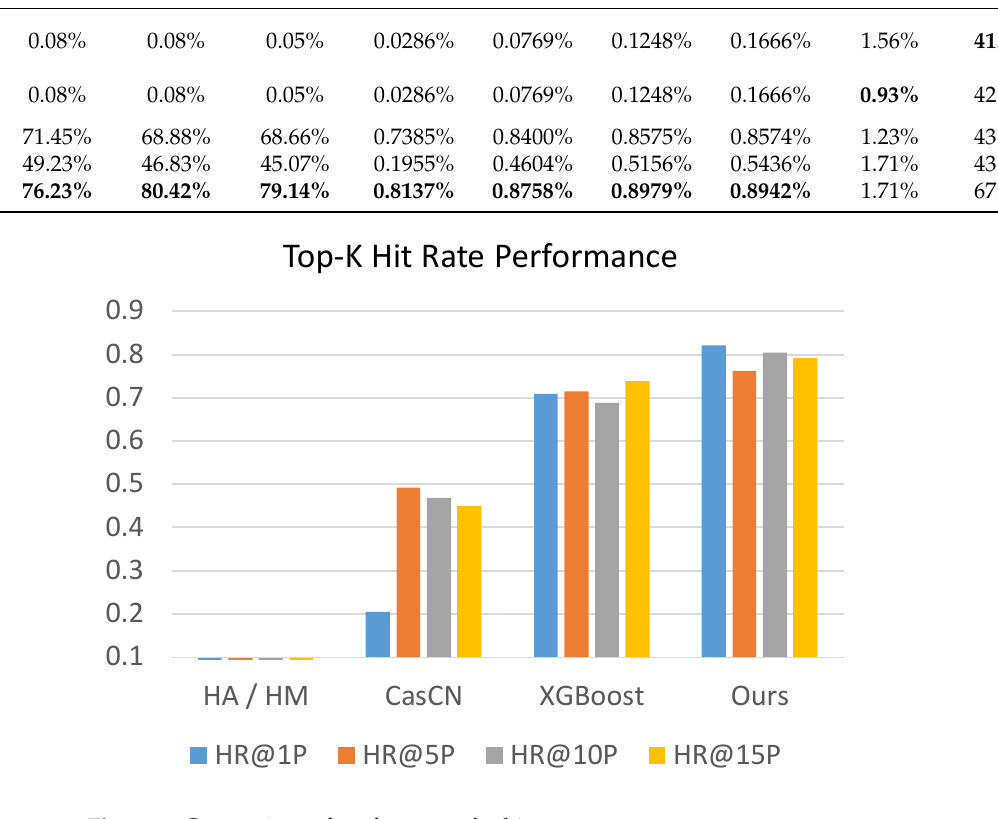
Figure 8. Comparison of performance for hit